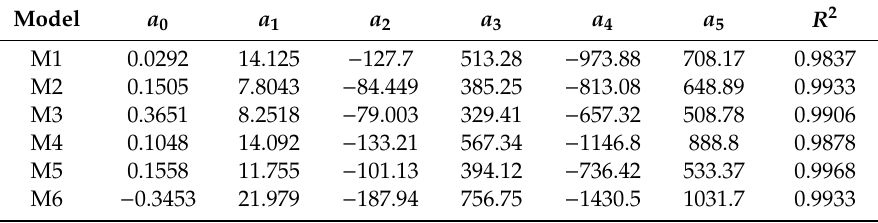
Table 6. Parameters of the regression analysis of discharge coe ffi